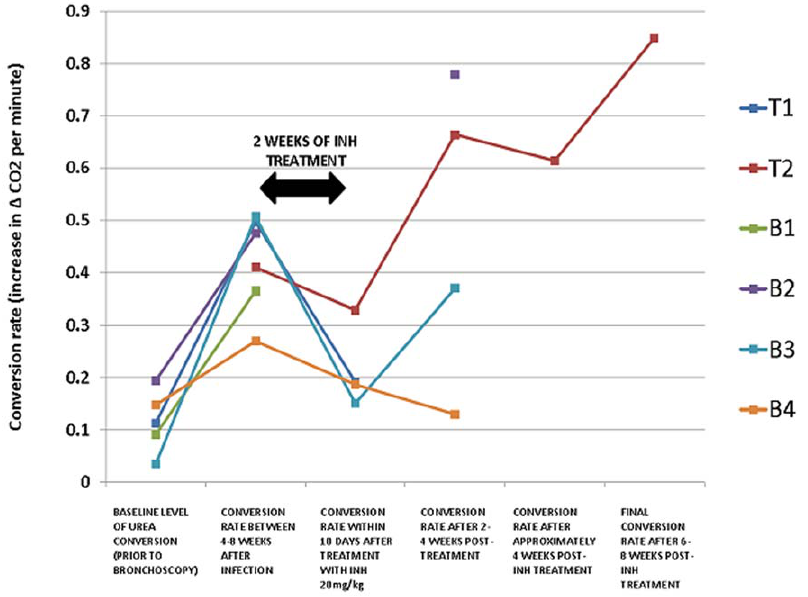
Figure 4. Conversion rate of [ 13 C]-urea prior and after treatment with INH. Baseline level of [ 13 C]-urea conversion was obtained on all animals prior to bronchoscopic infection. Urea conversion rates were obtained at a single time point after 4–8 weeks post-infection. INH 20mg/kg daily for a 2-week interval was initiated after 8 weeks from the time of infection. Conversion rates were ascertained either during or within 10 days of treatment cessation. Urease conversion were lastly determined at single time points after 2–4 weeks and 6–8 post-treatment in selected rabbits.